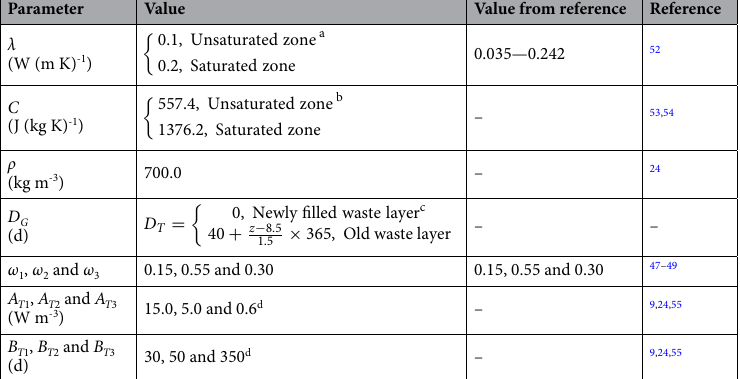
Table 1. Parameters of heat transfer model in the Wuxi landfill. a The heat conductivity of waste in the saturated zone was larger than that in the unsaturated zone 19,33 , and then the heat conductivities of waste in the saturated zone and the unsaturated zone were reasonably selected within the range of the literature value; b Based on the equation of the specific heat capacity of waste provided by Garg and Achari 35 , as shown in Eq. (7), the specific heat capacities for the unsaturated and saturated zones can be calculated according to the waste composition of Wuxi landfill provided by Zhang et al. 24 , and the specific heat capacity of each C s ( 1 − n )ρ s + C l nS l ρ l + C g n ( 1 − S l )ρ g ( 7 ) component provided by Yoshida et al. 53 and Miller and Clesceri 54 . C = ρ where, C is the specific heat capacity of waste (J (kg K) -1 ); C s , C l and C g are the specific heat capacities of each component, leachate, and landfill gas, respectively (J (kg K) -1 ); ρ , ρ s , ρ l and ρ g are the densities of waste, each component, leachate, and landfill gas, respectively (kg m -3 ); n is the porosity of the waste; S l is the liquid phase saturation. c In order to simulate the temperature at the bottom of monitoring well, which was placed after the waste body was excavated, the length of time that the waste in the new waste layer had been degraded to produce the temperature was set to 0; 40 was the average length of time for the existence of the new waste layer (d); 8.5 was the thickness of the new waste layer (m); 1.5 was the average height for placing the waste in the old waste layer each year (m); d A T / e was the peak value of heat production rate in this model, so A T in Fig. 3 3 A T was equal to the peak heat rate in the literature multiplied by e (natural constant). A T = ω i (cid:31) and i = 1 i 3 B T = ω i (cid:31) B T were based on the data provided by Hanson et al. 9,55 and the actual situation of the Wuxi i = 1 i landfill, A T i and B T i were obtained using the method of empirical fitting, as shown in Fig.